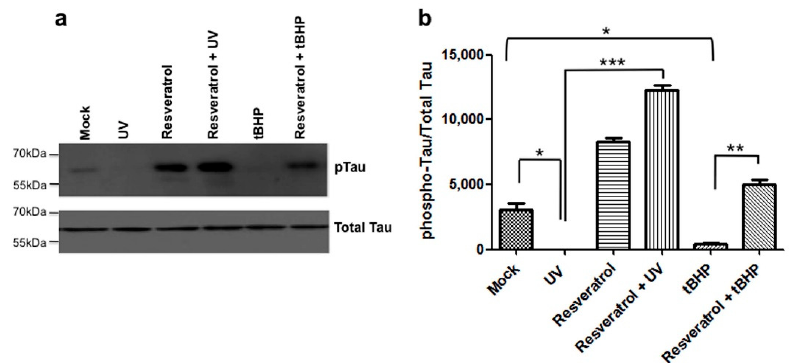
Figure 4. Resveratrol prevents dephosphorylation of tau at Ser 422 . ( a ) C6 cells were pretreated with resveratrol and then exposed to tBHP or UV irradiation. Tau phosphorylation at Ser 422 was determined immunoblotting and ( b ) quantified; ( b ) Resveratrol significantly ( p < 0.05) increased tau phosphorylation at Ser 422 when pretreated prior to UV-irradiation. Resveratrol also increased tau phosphorylation at Ser 422 when pretreated prior to tBHP treatment, but to a lesser extent than when pretreated prior to UV-irradiation ( p < 0.05). UV-irradiated C6 cells showed a significant decrease in tau phosphorylation compared to mock treated cells (*, p = 0.0347). C6 cells that were UV-irradiated and pretreated with resveratrol showed a significant increase in tau phosphorylation compared to UV-irradiated c6 cells alone (***, p = 0.0009). C6 cells treated with tBHP showed a significant decrease in tau phosphorylation compared to mock (*, p = 0.0471). C6 cells treated with tBHP and pretreated with